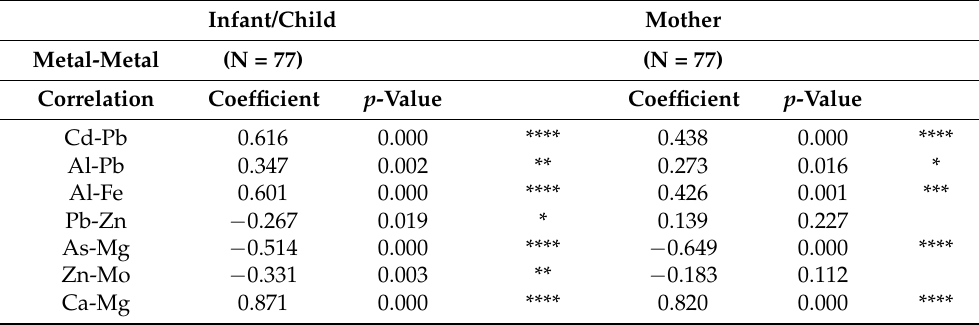
Table 3. Relationship of metal-metal pair concentrations in infants/children and in their mothers. Infant/Child